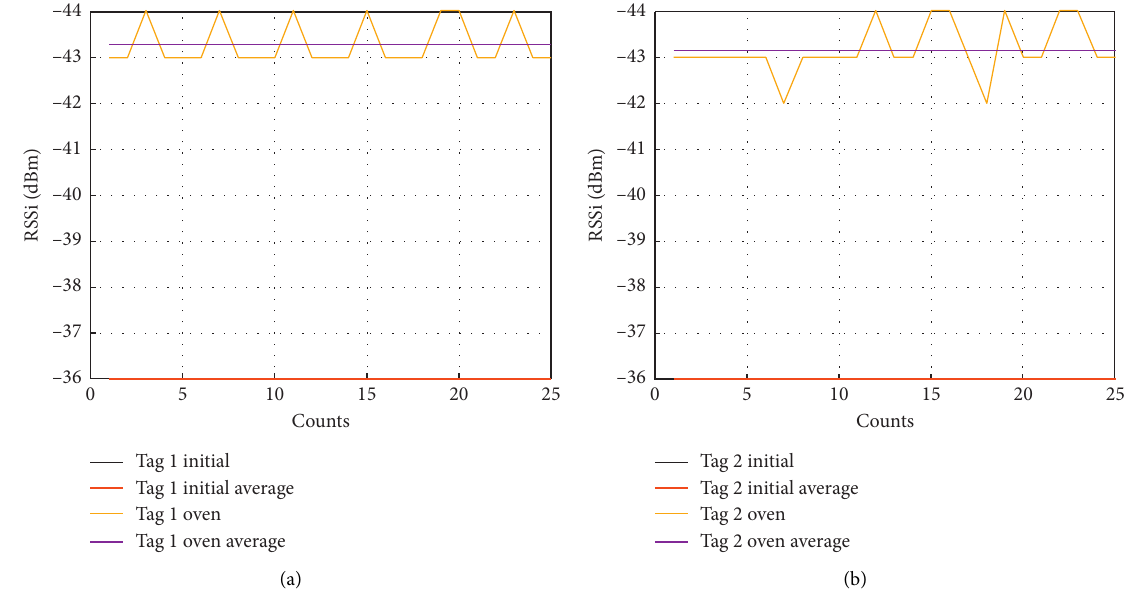
Figure 10: Change in backscattered signal strength during the unbent and subsequent bending states for Tag 1 (a) and Tag 2 (b).